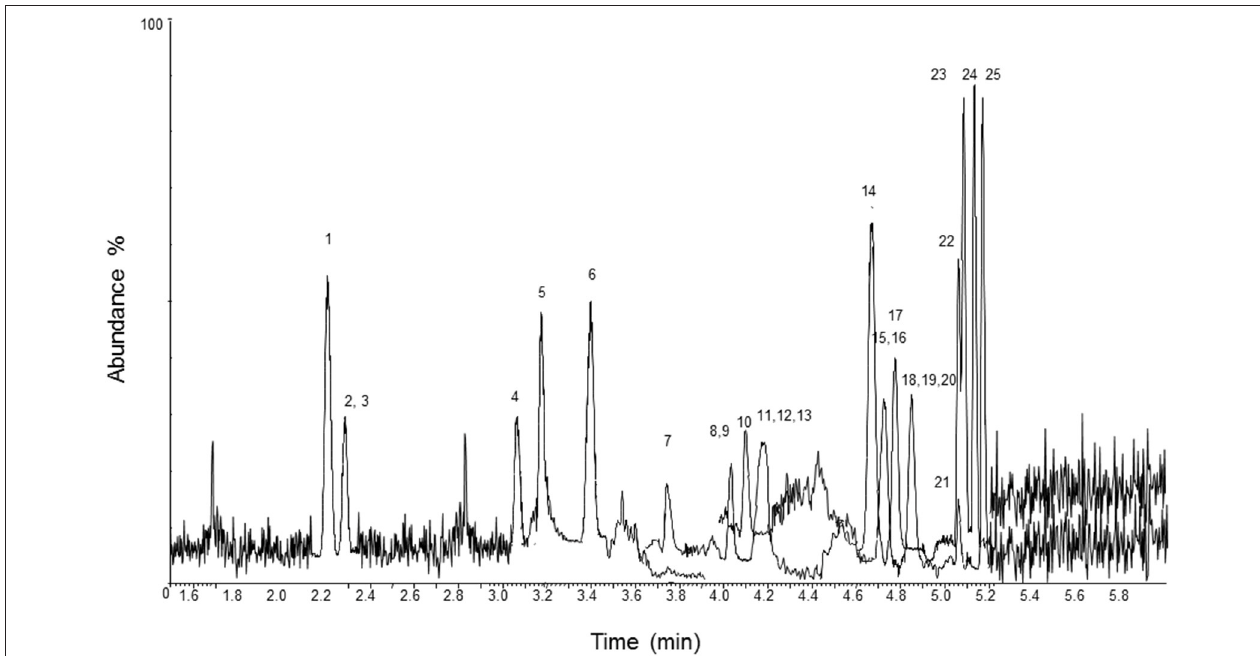
FIGURE 3 | LC-MS/MS chromatogram of a hair sample fortified with the analytes at the limit of quantification and their ISs. 1, methoxyacetyl norfentanyl; 2, acetyl norfentanyl; 3, acetyl norfentanyl-D5; 4, norfentanyl; 5, furanyl norfentanyl; 6, cyclopropyl norfentanyl; 7, butyryl norfentanyl; 8, butyrylfentanyl carboxy metabolite;